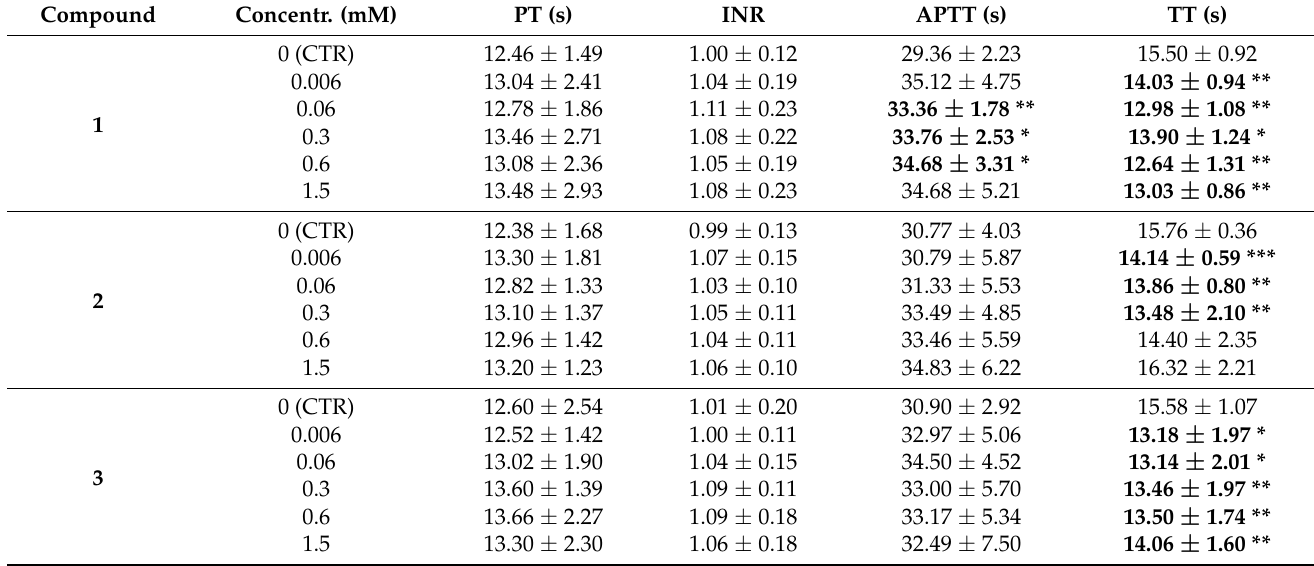
Table 3. The effects of compounds 1 – 5 on basic coagulation